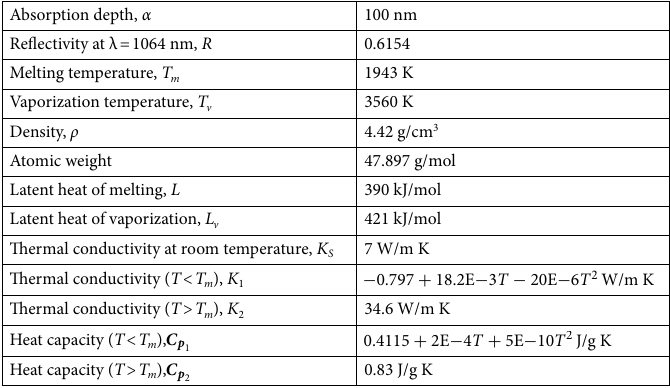
Table 1. Thermal and optical properties of Ti-6Al-4V used in the laser heating